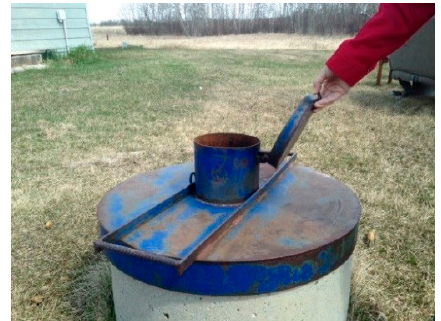
Figure 4. Household water cistern.